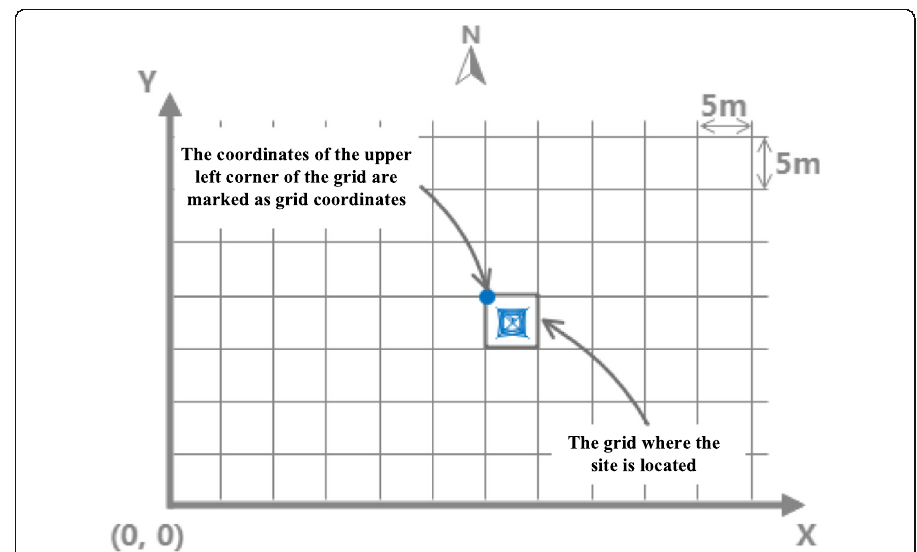
Fig. 1 Coordinate description of rasterized map